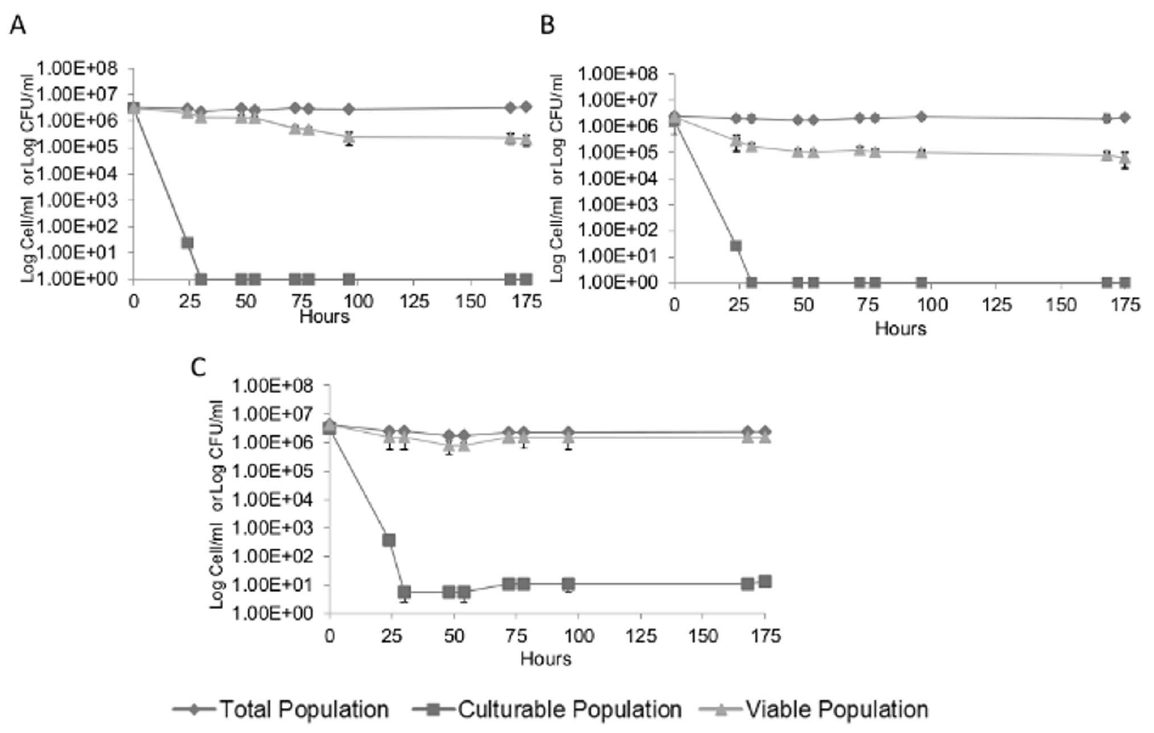
Figure 8. The induction of the VBNC state in S.cerevisiae BDY4742 (Panel A), BDY4742 D ssu1 (Panel B) and BDY4742 D ssu1 pCEL13 SSU1 (Panel C) strain in synthetic wine with the addition of 4.5 mg.L 2 1 molecular SO 2 . Total cell counts ( ¤ ), culturable counts ( & ), and viable counts ( m ).Value 1 corresponds to an undetectable number (less to 10 CFU/mL). The values presented are the average of three replicates of three separate experiments.